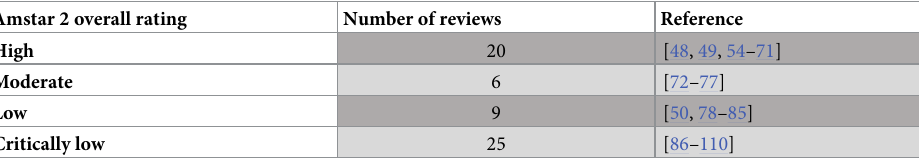
Table 2. Quality assessment of included